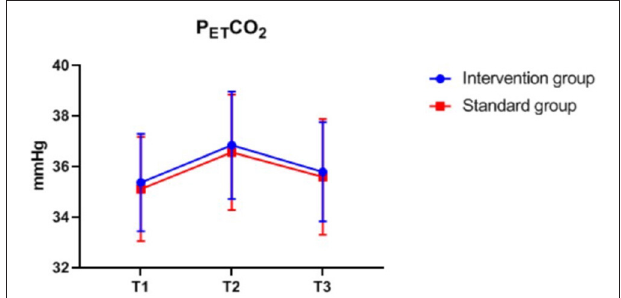
FIGURE 5 | Contralateral rSO 2 over time. rSO 2 , regional cerebral oxygenation. The measurement time interval after general anesthesia but before clamping the carotid artery was recorded as baseline reference T1, the time interval after clamping but before declamping was recorded as T2, and the time interval after the declamping and stabilization of cerebral perfusion but before completion of surgery was recorded as